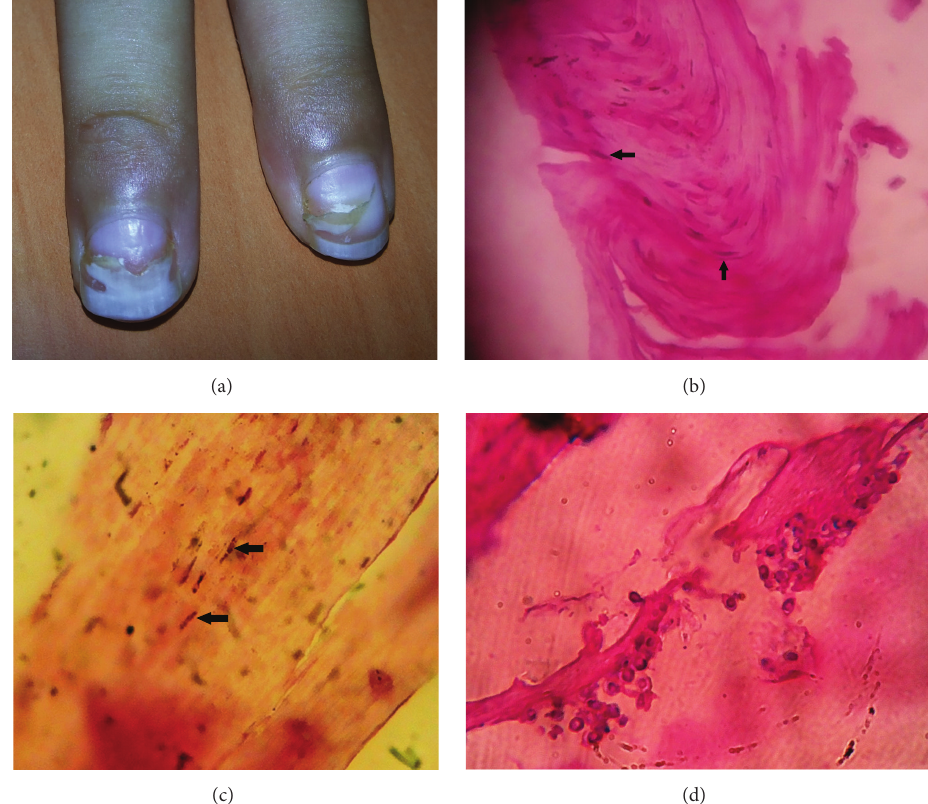
Figure 1: (a) Thickened, discolored, and sloughed out nail; (b, c) the H&E preparations showing thin hyphae (arrow head); (d) another H&E preparation that shows yeast cells with coarse pseudomycelia (giant